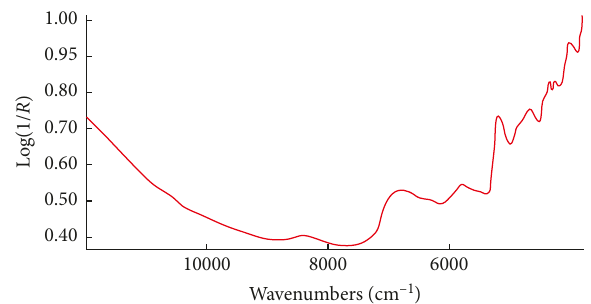
Figure 1: A typical absorbance (log(1/ R )) spectrum of tea in the wavenumbers from 12,000 to 3800cm